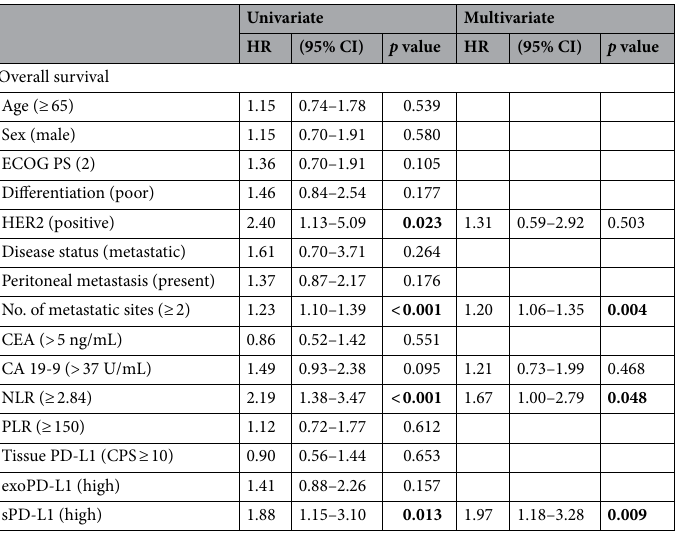
Figure 5. Correlation between types of T cells and exoPD-L1. ( a – c ) The correlation between exoPD-L1 level and the frequency of total T cells ( a ), CD4 + T cells ( b ), and CD8 + T cells ( c ). ( d ) The low exoPD-L1 group showed a higher frequency of CD8 + T cells than the high exoPD-L1 group. ( e ) The high exoPD-L1 group showed a tendency to be higher frequency of PD-1 + CD8 + T cells. ( p = 0.070) Unpaired t -test was performed between two groups.